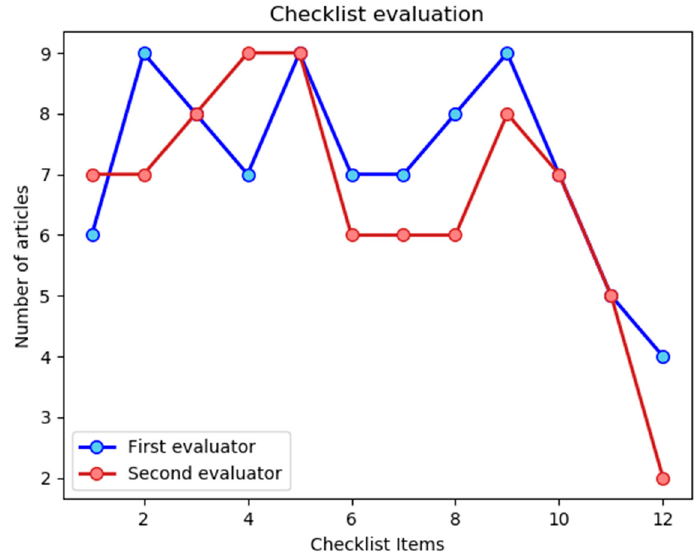
Figure 2. Plot of the number of selected articles that satisfy each of the items of the checklist introduced in Table 1.